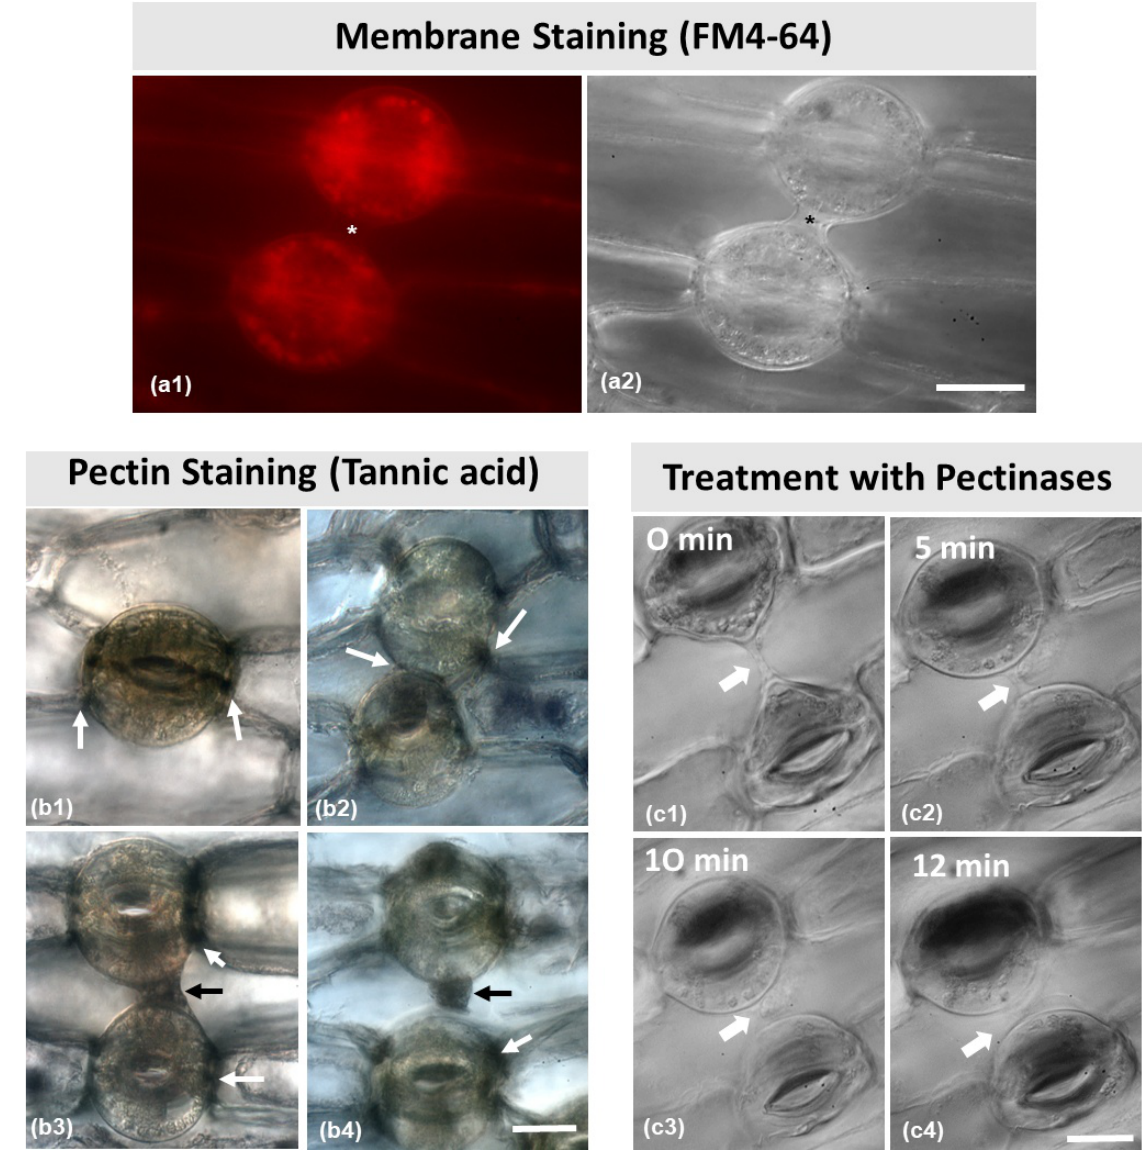
Figure 7. ( a ) Membrane staining with FM 4–64 ( a1 ). No signal can be observed in the structure connecting the dorsal cell walls (asterisks in a1 , a2 ) of two adjacent stomata (also imaged with DIC optics in ( a2 ). ( b ) Tannic acid–ferric chloride staining for localization of pectins. Arrows point to pectin localization. Pectins are located at the junction sites of the dorsal cell walls with the neighboring epidermal cell ( b1 ), at the junction sites of the dorsal cell walls of the adjacent stomata ( b2 ), and at the strand connecting the dorsal cell walls of two adjacent stomata ( b3 , b4 ). ( c ) Consecutive photographs ( c1 – c4 ) of a pair of adjacent connected stomata during treatment with 3% pectinase solution (treatment duration as noted on each figure). The connection between the stomata gradually disappears. Scale bars = 20 μm.